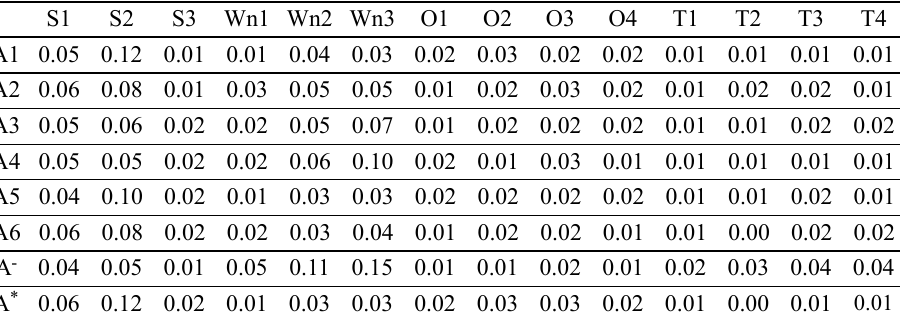
Table 12. The weighted decision